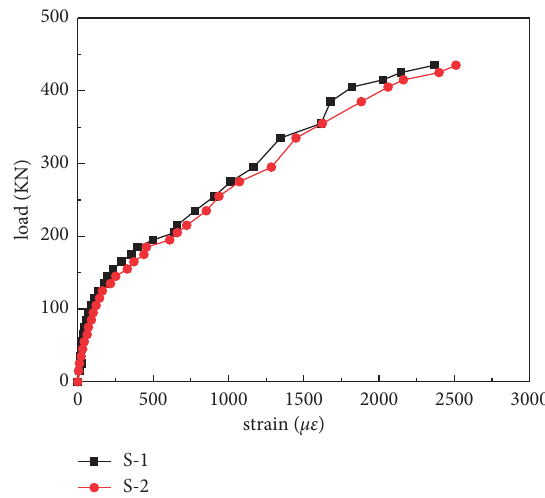
Figure 9: Curve of load-strain relation of tensile steel bar.